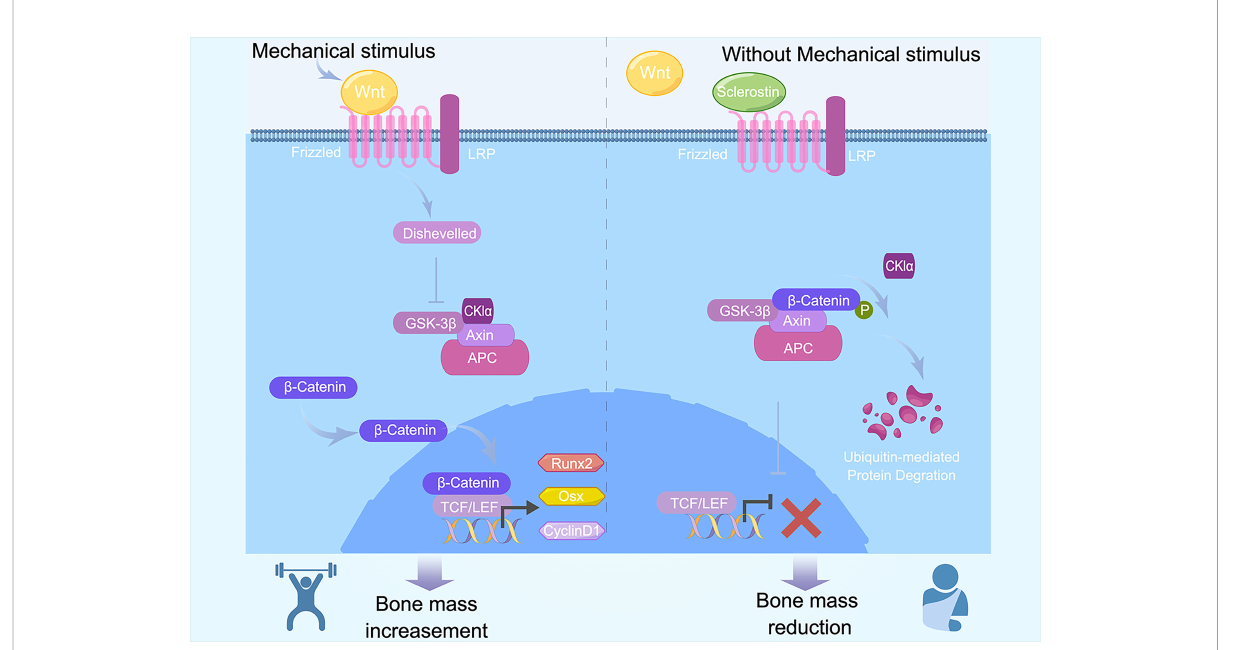
FIGURE 2 Canonical Wnt signaling and sclerostin in mechanical regulation of exercise. Exercises produce mechanical stimulus and increase Wnt1. Wnt1 binds with LRP5/6, subsequently activate intercellular Dvl, resulting in release offree b -catenin and translocation into nuclei. b -cateniin binds with TEF/ LEF, contributes to induction and activation of Runx2, Osx, and cyclinD1. Osteoblast differentiation and bone mass increase is activated by Wnt and inhibited by the Wnt antagonists Frizzled and sclerostin. When without mechanical stimulus bring by exercise, Wnt1 decreased and b -catenin is ubiquitinated and degraded, inducing downregulation in the expression of downstream target gene, bone mass subsequently